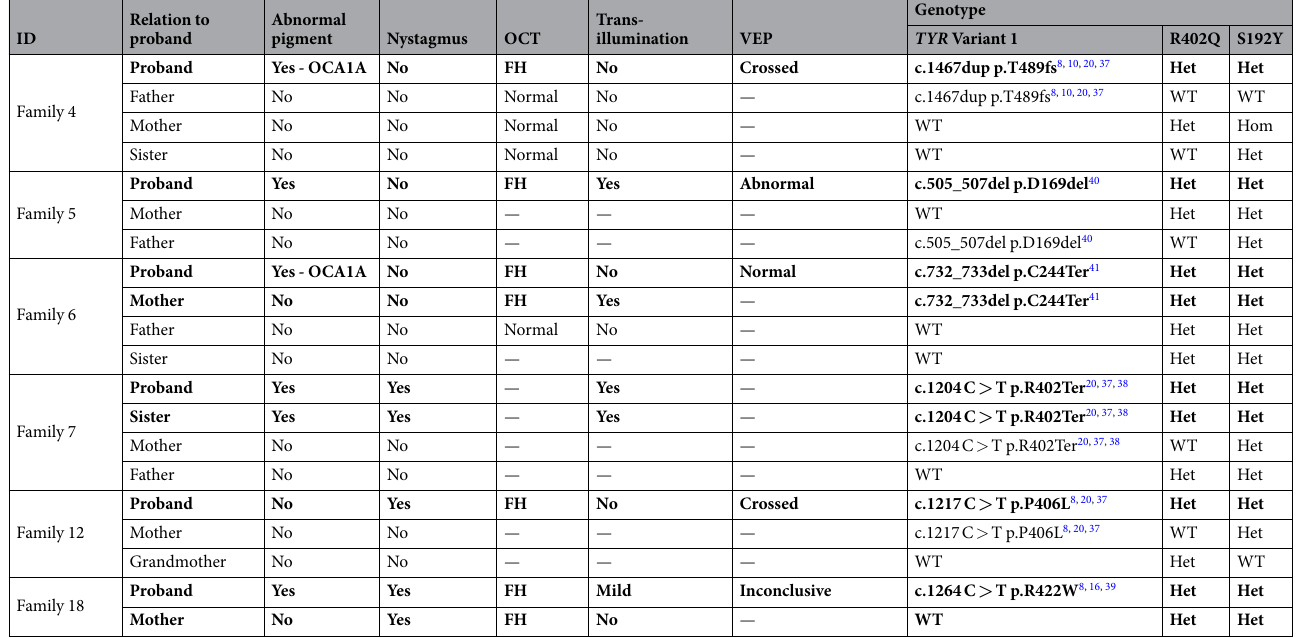
Table 3. Phenotype-genotype table of families with Sanger-confirmed TYR variants. Family number corresponds with proband number. Phenotype information (from left to right): cutaneous and hair pigmentation in context of family background, presence of nystagmus, foveal hypoplasia (FH), iris trans- illumination, and VEP asymmetry indicating (over)crossing of the optic nerve. Those with partial albinism are